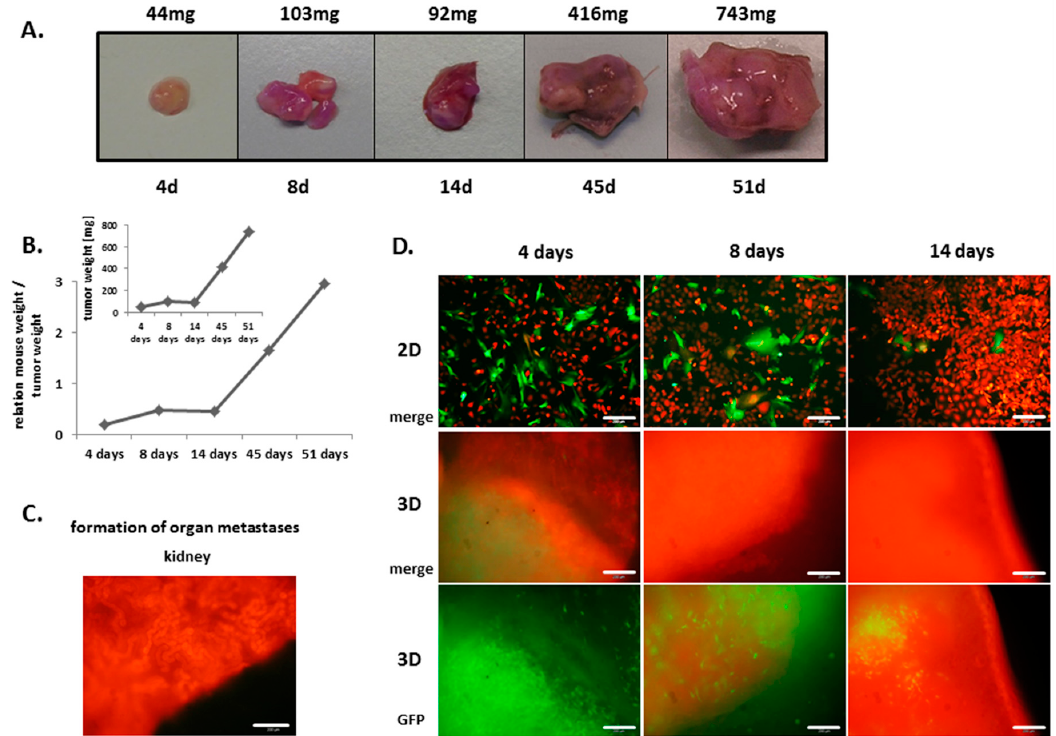
Figure 1. ( A ) NOD/scid mouse tumors were derived following subcutaneous co-injection of 2 × 10 6 human MSC300415 GFP with 2 × 10 6 MDA-MB-231 cherry breast cancer cells for different time points (4 days, 8 days, 14 days, 45 days, and 51 days). ( B ) Ratio of mouse weight to tumor weight was compared within different time points. The diagram insert represents tumor weight only. ( C ) Formation of distant metastases was evaluated in mice after 45 days and 51 days of tumor development by investigation of cherry- and green fluorescent protein (GFP)-fluorescence in organs. One exemplary picture from kidney metastasis is documented. Bars represent 200 µ m. ( D ) Morphology and cell ratio of 2D co-cultures between MSC300415 GFP and MDA-MB-231 cherry was compared to appropriate 3D tumor tissues after 4 days, 8 days, and 14 days as documented by GFP fluorescence microscopy and by a merge of mcherry and GFP fluorescence (merge). Particularly the 3D fluorescence micrographs (merge) after 8 days and 14 days demonstrate a diffuse red fluorescence within the tumor tissue indicating a predominant majority of breast cancer cells. Bars represent 200 µm.